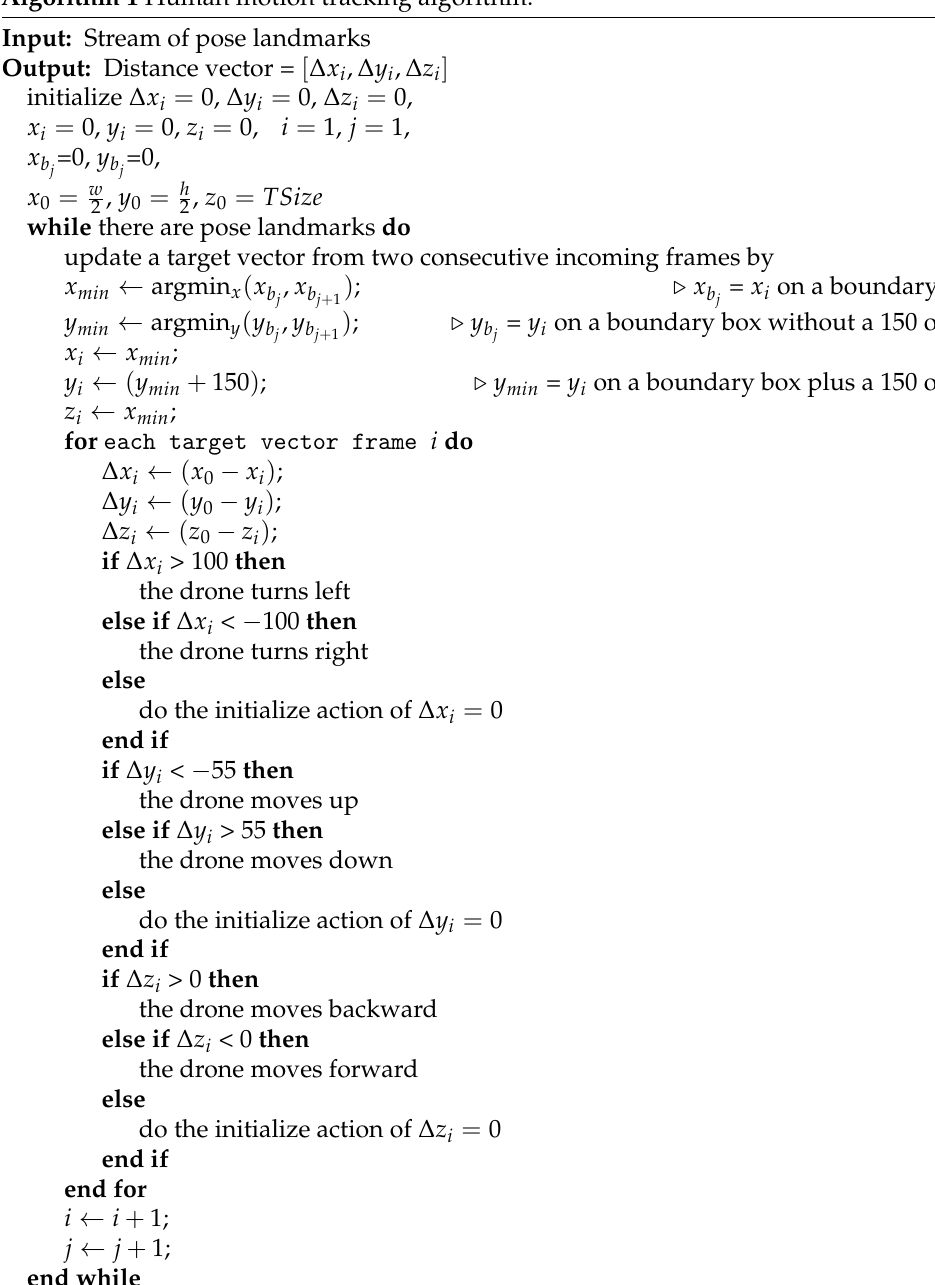
Algorithm 1 Human motion tracking